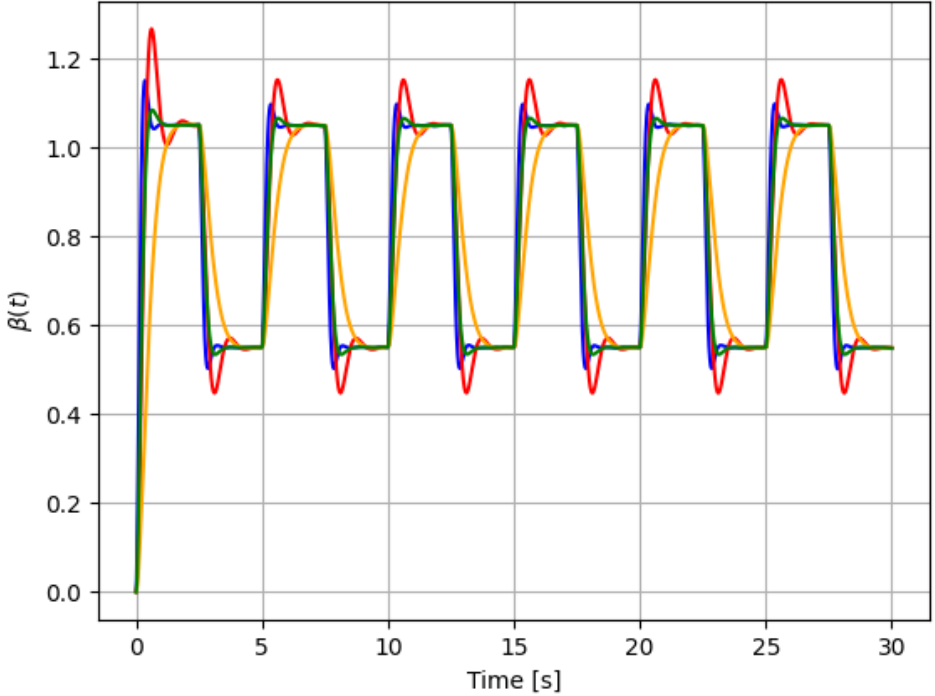
Figure 6. Pitch actuator responses to command in Figure 5: H (blue), F 1 (red), F 2 (orange), and F 3